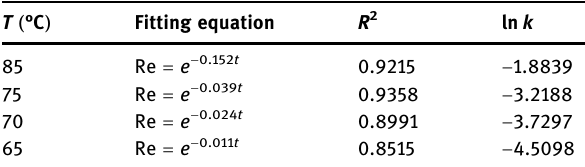
Table 3: Fitting equation of impact resistance degradation